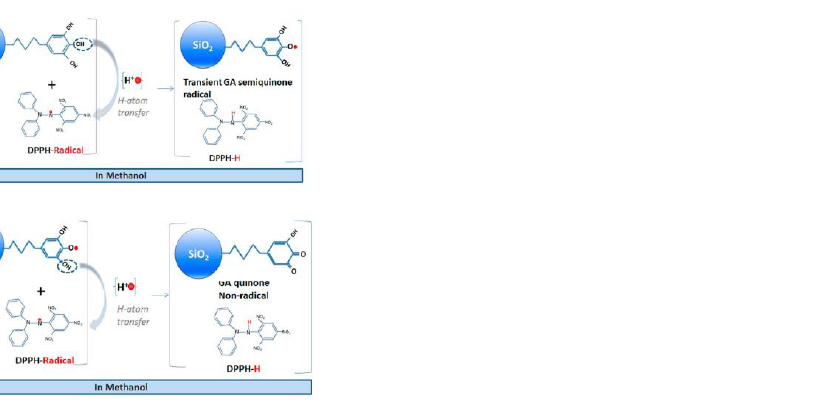
Figure 21. Schematic representation of the Hydrogen-Atom Transfer [HAT] from ( a ) the GA molecule forming to a transient GA radical, and ( b ) a GA semiquinone forming a nonradical GA quinone. Reprinted (adapted) with permission from [88]. Copyright 2023 American Chemical Society.